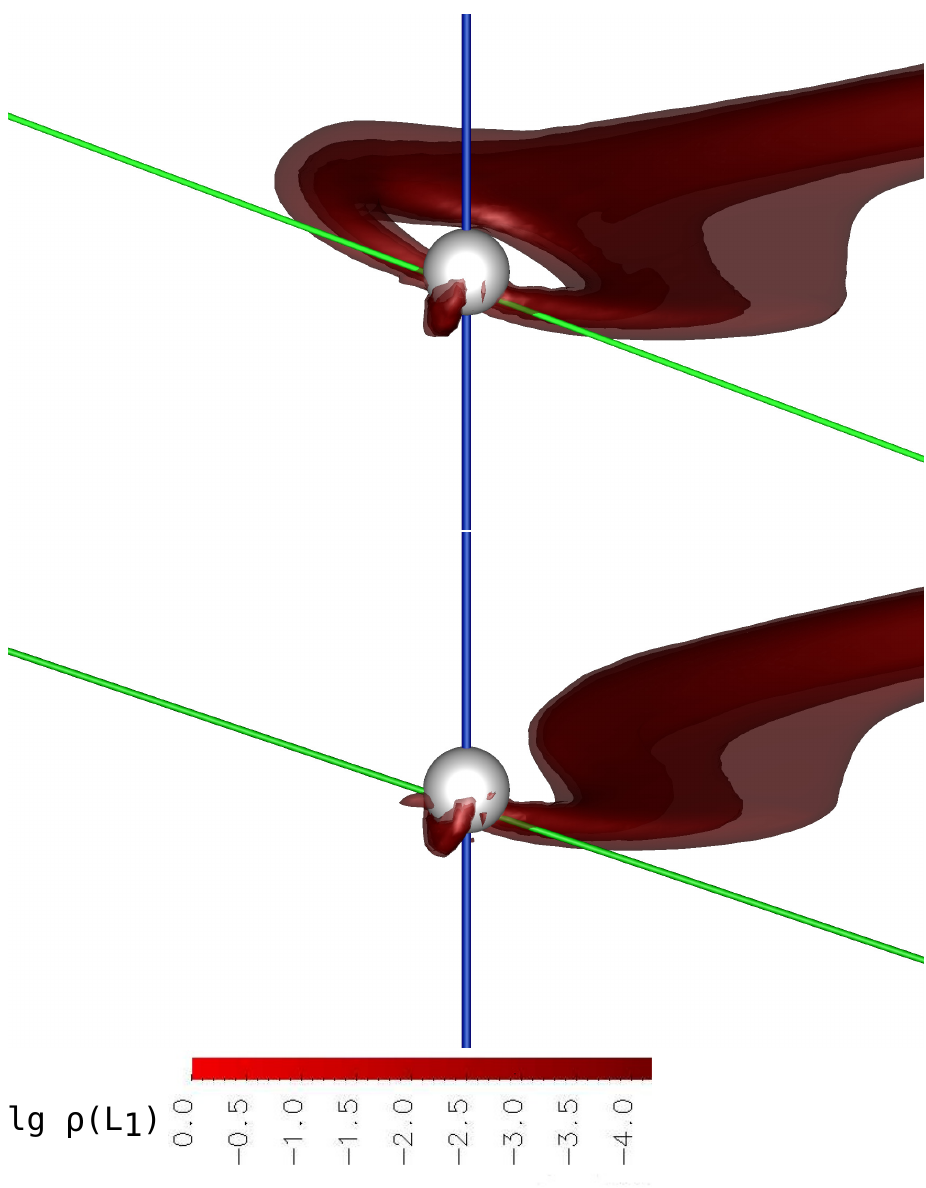
Figure 13. The same as in Figure 12, but for Phase 3 ( upper panel) and Phase 4 ( lower panel). It can be seen from the tables that the dipole displacement leads to different behavior of the total accretion rate for both switching processes. When the jet closes to the north magnetic pole in the first process, a sharp increase in the accretion rate is observed in Phase 4. This indicates the effect of matter accumulation in the jet during the formation of an arch in the magnetosphere of the white dwarf and its subsequent discharge to the magnetic pole. In addition, due to the shift of the dipole axis, the north pole is closer to the Lagrange point L 1 than the south one, which also contributes to a local increase in the accretion rate. When switching back from the north pole to the south one, the accretion rate experiences a slight drop, and the process of changing the magnetic poles proceeds smoothly. In this case, despite the fact that the field strength in the vicinity of the south pole is higher than the north one, the south pole is removed from the inner Lagrange point at a greater distance and is weaker from the point of view of accretion. If we compare the tempo values for the south pole in the first switch in Phase 1 and in the second switch in Phase 4, they turn out to be approximately equal. For the north pole in Phase 1, the accretion rate is initially slightly higher than for the south one, and after the first switching in Phase